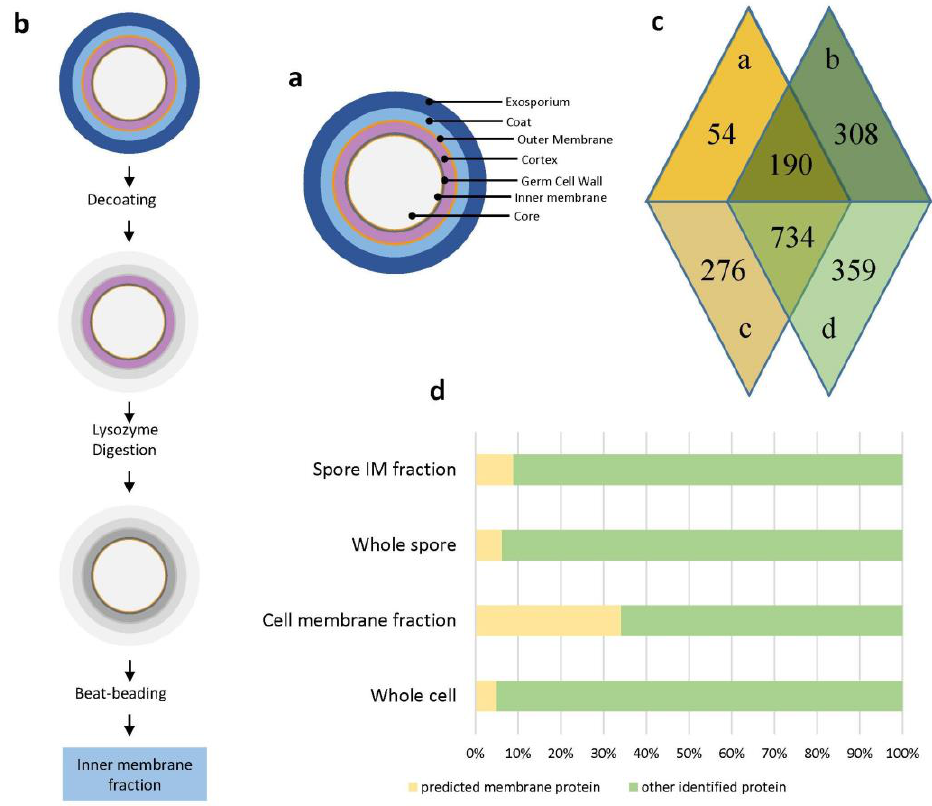
Figure 1. Spore structure, membrane enrichment and identified proteins from B. cereus spore inner membrane and vegetative cell membrane. ( a ) Spore structure. ( b ) Workflow for inner membrane enrichment. ( c ) Predicted localization of proteins identified from membrane factions of B. cereus spores and cells. (Triangle a) the number of predicted spore inner membrane proteins; (Triangle b) the number of predicted cell membrane proteins; (Triangle c) the number of other spore proteins identified in spore inner membrane fraction; (Triangle d) the number of other cell protein identified in cell membrane fraction. ( d ) Percentage of predicted membrane protein levels in each